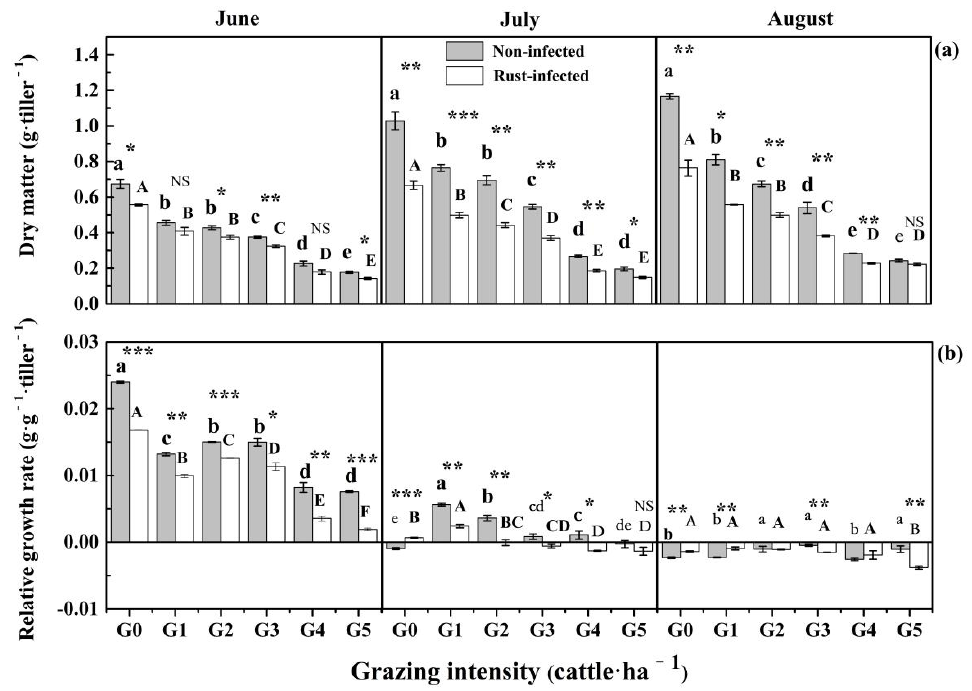
Figure 2. Influence of grazing intensity on the dry matter ( a ) and relative growth rate ( b ) of non- infected and rust-infected Leymus chinensis from June to August based on the 2-year (2015 and 2016) average (error bars denote standard errors). Different lower-case and upper-case indicate significant differences among grazing intensities, respectively. The asterisk (*) indicates significant differences between non-infected and rust-infected plants (***, p < 0.001; **, p < 0.01; *, p < 0.05; NS, p > 0.05).